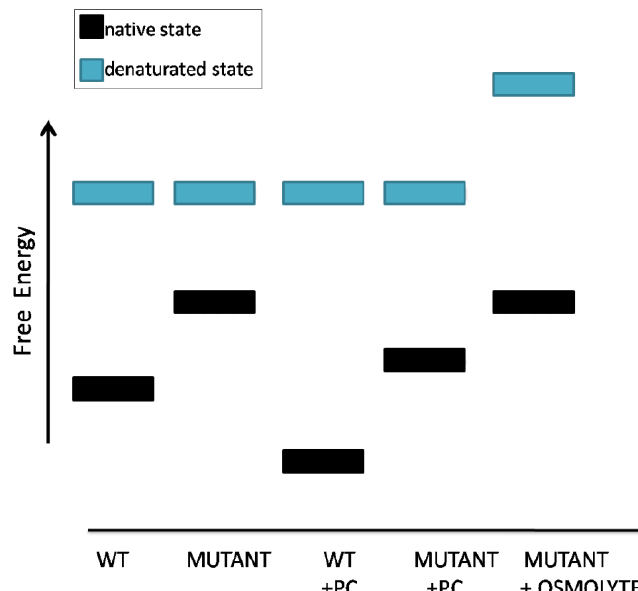
Figure 6. Schematic representation of the effects of pharmacological chaperones or osmolyte chemical chaperones on protein stability.